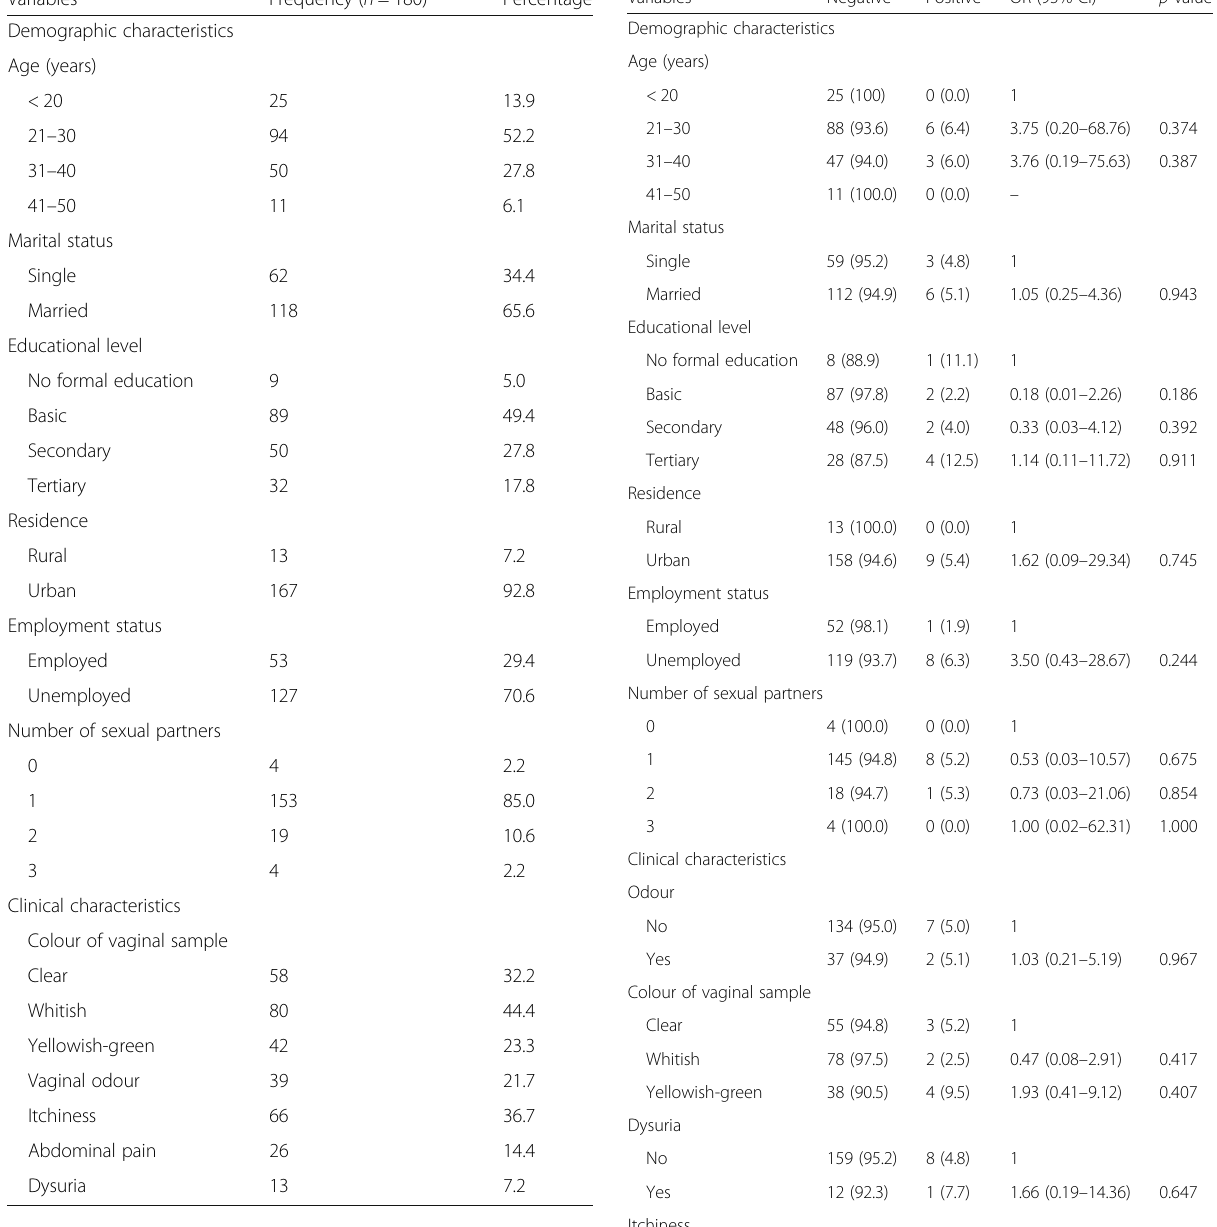
Table 1 Demographic and clinical characteristics of the study